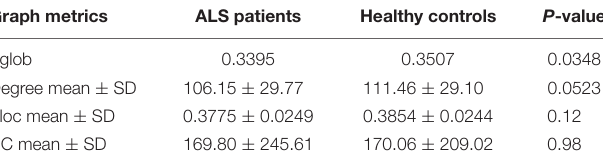
TABLE 2 | Global network